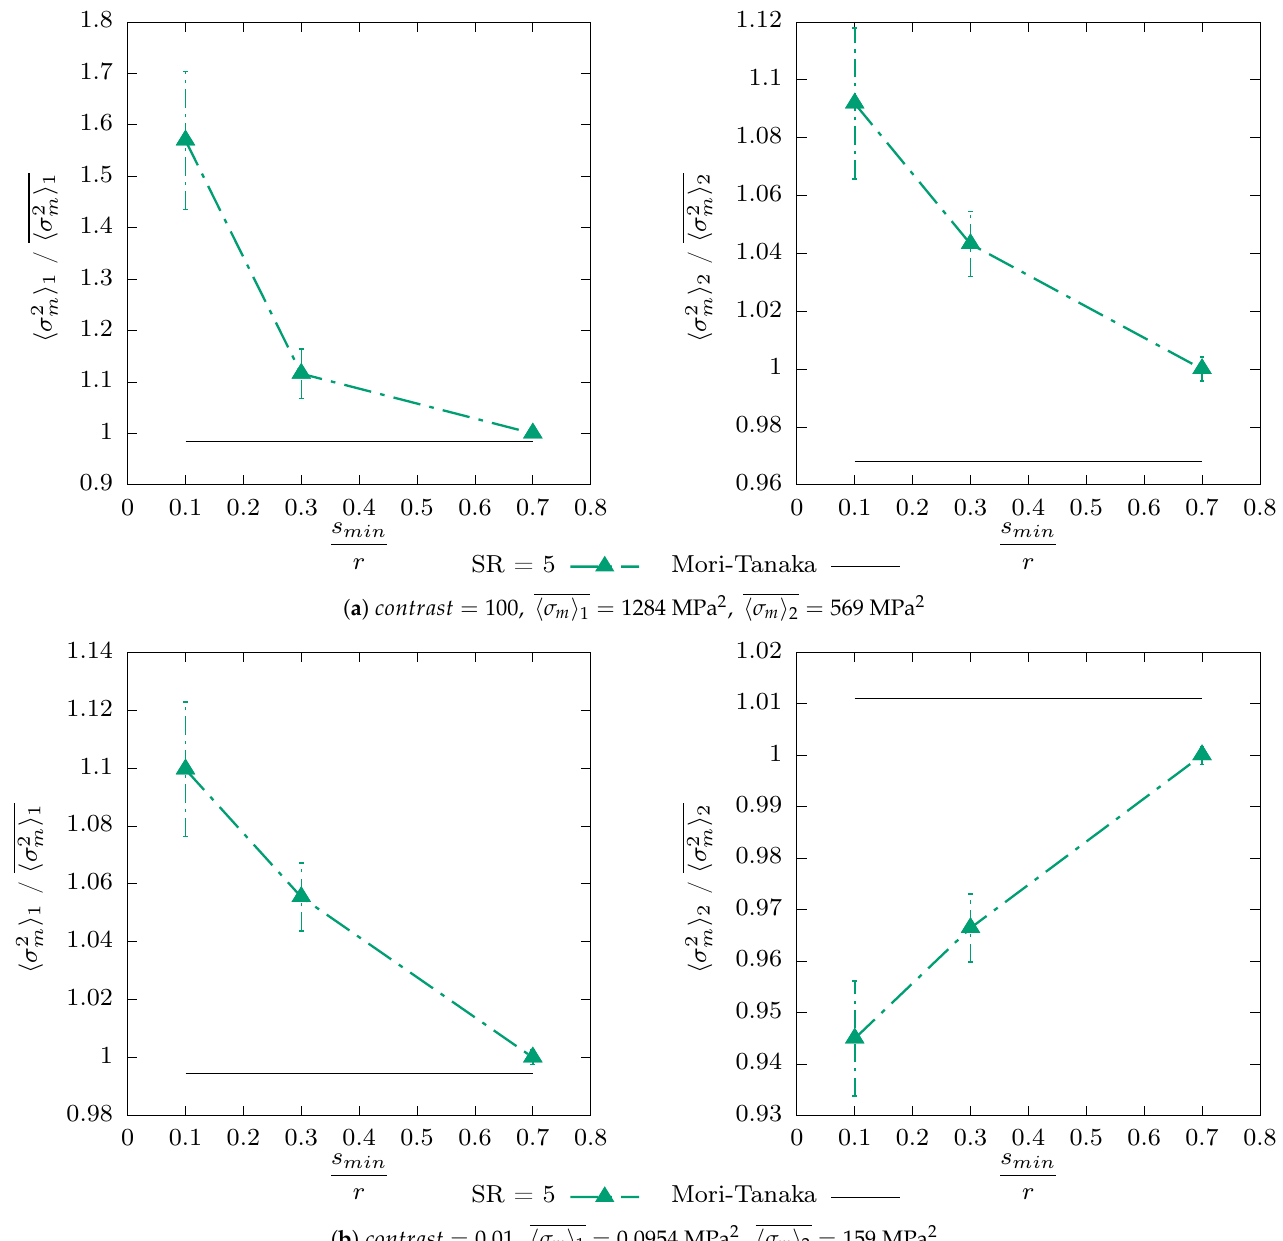
Figure A7. Mean values and standard deviations on the mean value for the second moment of hydrostatic stress by phase as a function of the packing parameter s min / r ( r = 10 µ m) for a volume fraction of inclusions f v = 25.1